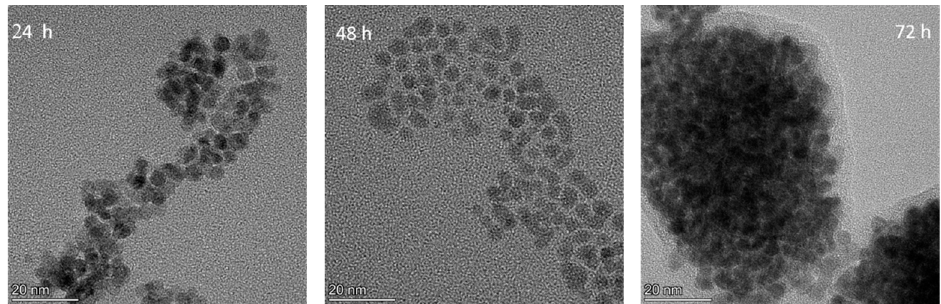
Figure 5. TEM images of i -Pd(OAc) 2 (TPPTS) 2 that impregnated for different duration times in ethanol. Impregnation conditions: i -Pd(OAc) 2 (TPPTS) 2 (10 µ mol, Pd), 5 mL ethanol, 60 ◦ C, 1 atm air.